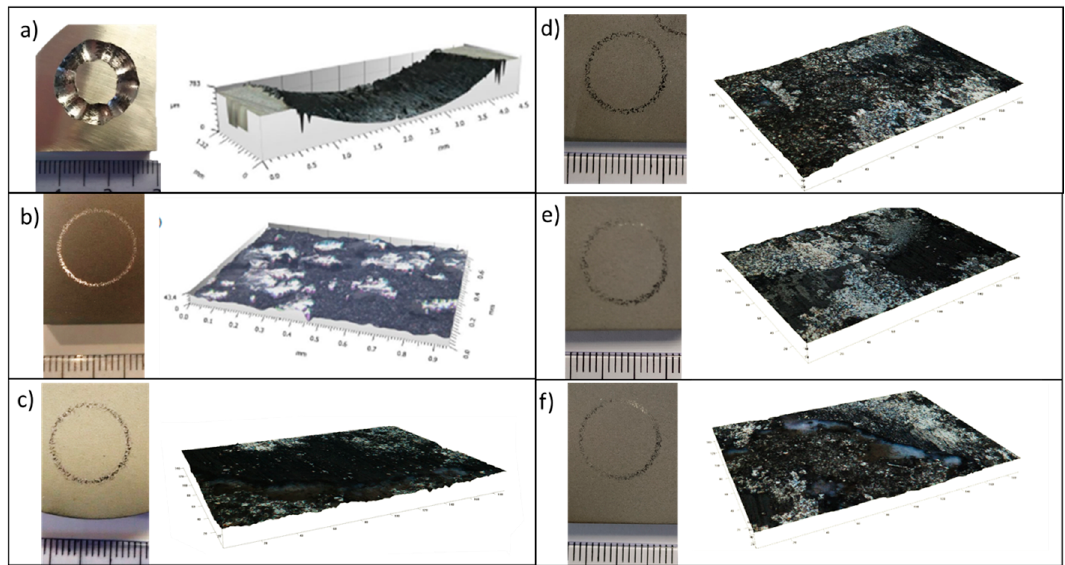
Figure 10. Optical macrographs and 3D optical profiler micrograph of the wear track of ( a ) ZE41 magnesium alloy, ( b ) 1L-1, ( c ) 2L-1, ( d ) 2L-2, ( e ) 2L-3, and ( f ) 2L-4.